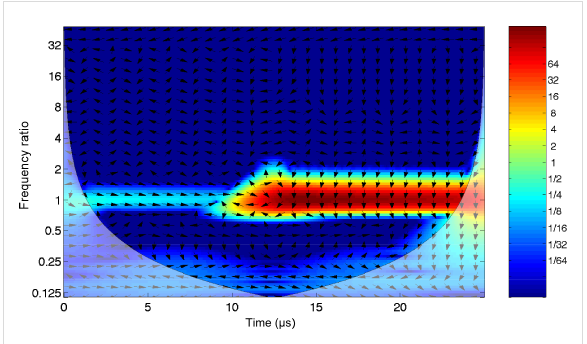
Figure 7: Wavelet cross-correlation between a sinusoidal reference signal at resonance and the damped harmonic oscillator response (quality factor Q = 40), to a sinc driver, as shown in Figure